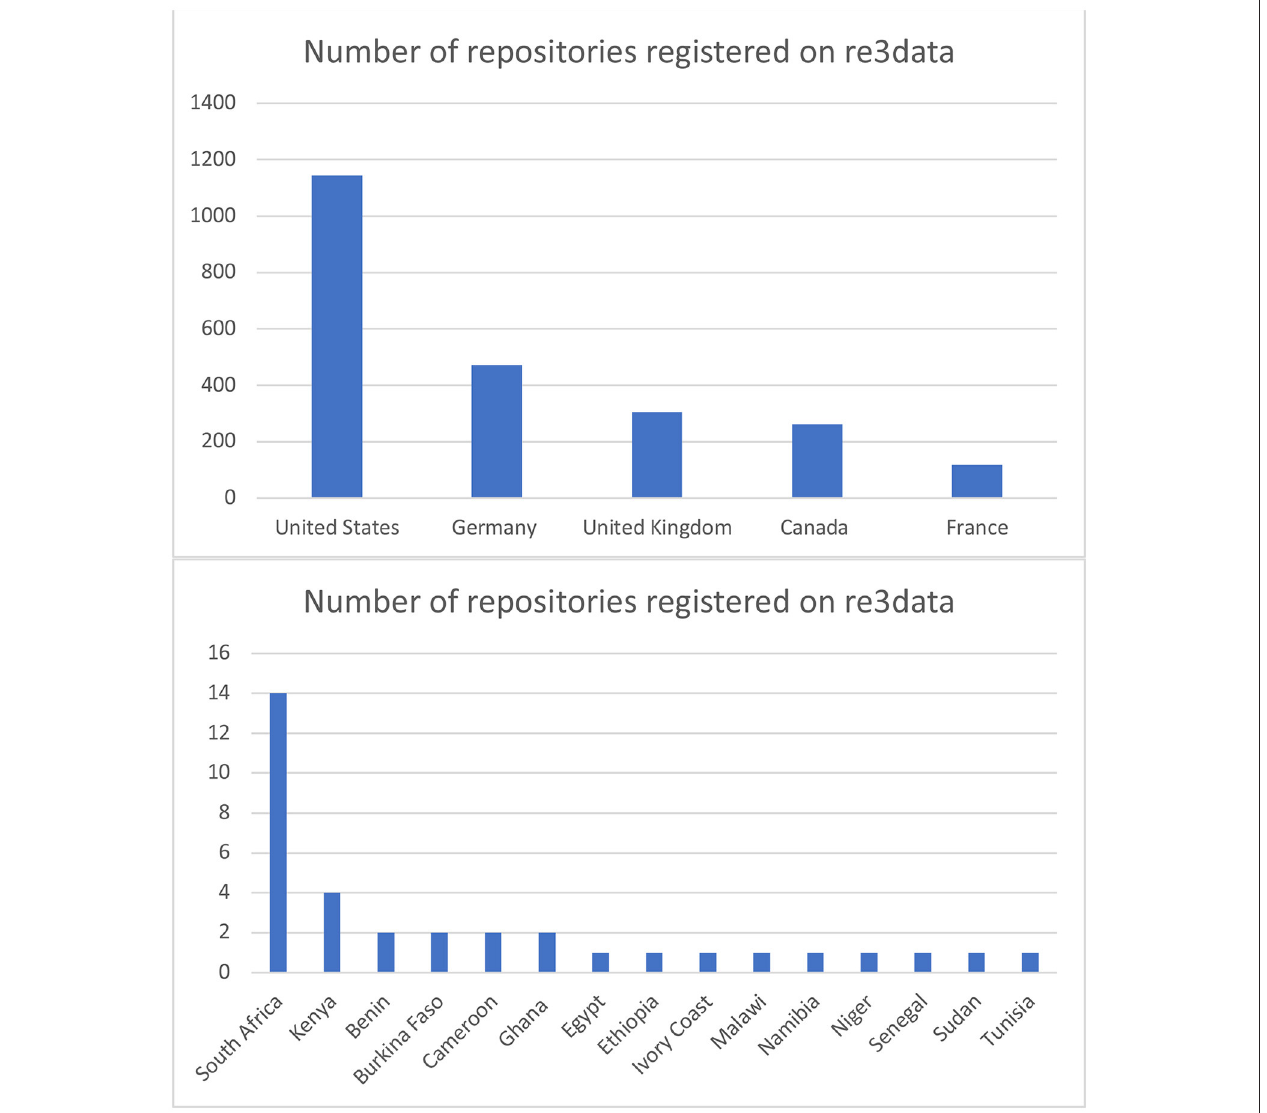
FIGURE 1 | Distribution of repositories within Re3Data according to geographic location in 2022. Available online at: https://www.re3data.org/browse/by-country/ (accessed April 4,